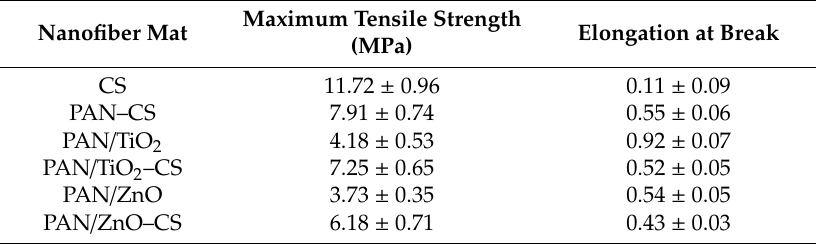
Figure 12. Bilayer nanofiber mats tensile stress–strain curves. For comparison, the stress–strain curves of single layers of CS and the PAN / MO nanofiber mats are also shown by the dotted and dashed lines, respectively. Table 4. Maximum tensile stress values and elongation at break for di ff erent